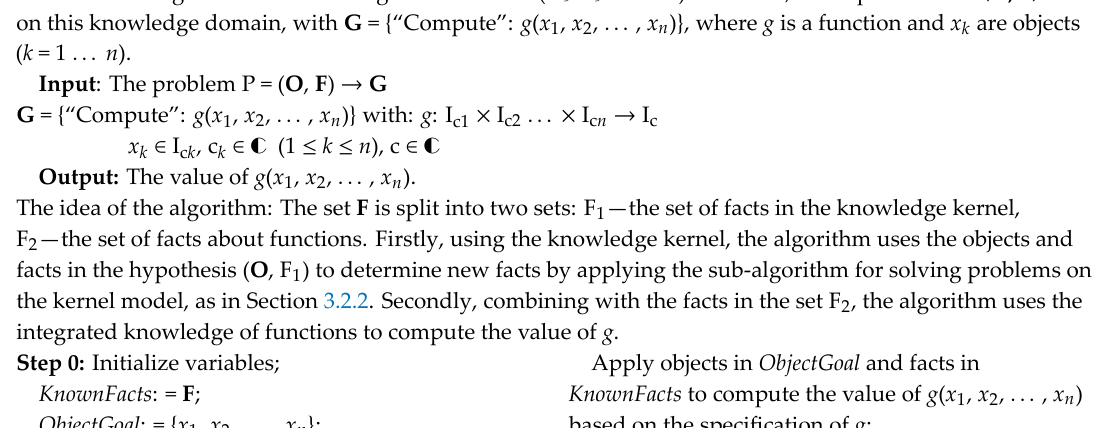
Algorithm 3. Compute the value of a function.